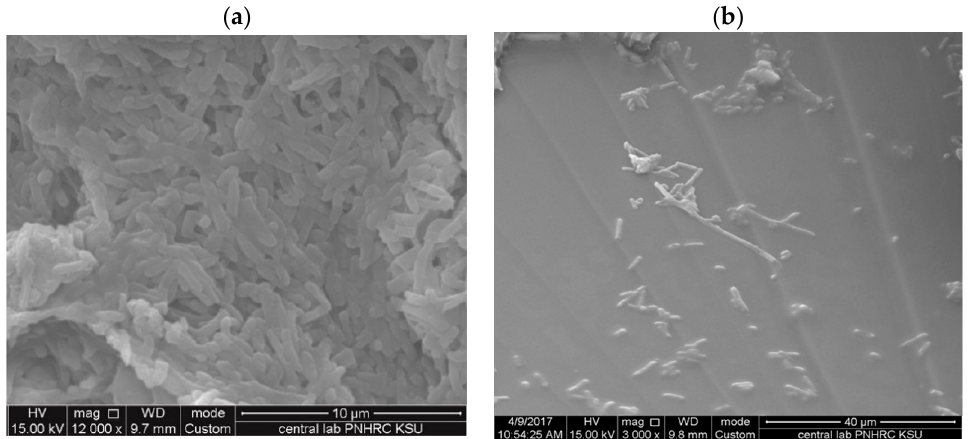
Figure 11. Morphology of untreated Pseudomonas sp. ( a ) and the morphological alteration (elongation) after application of O-AgNPs fabricated using O. forsskalii seeds ( b ).